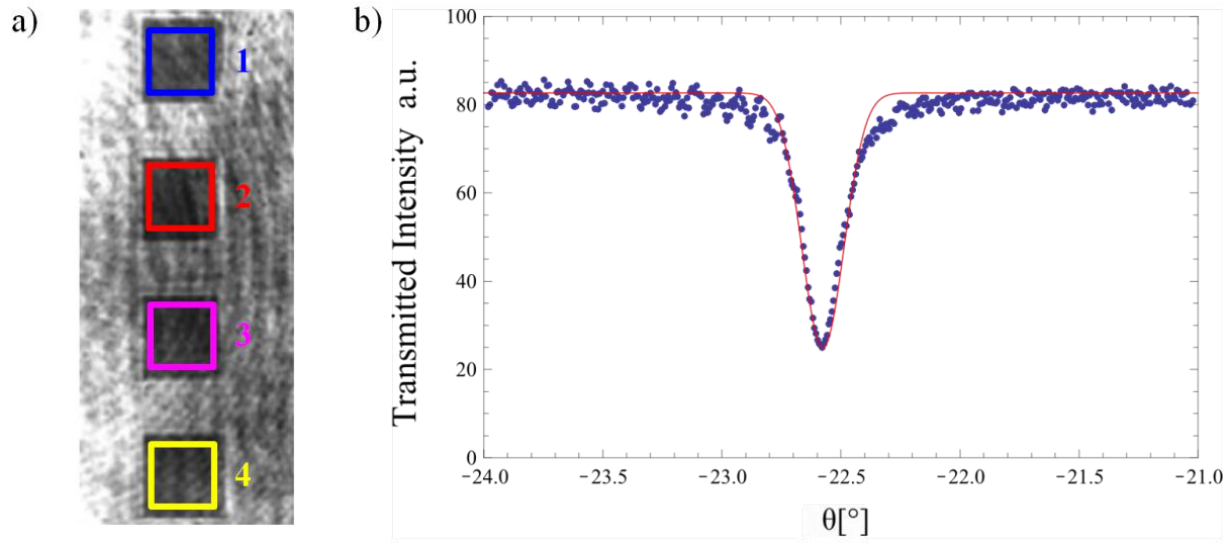
Figure 6. Typical measurement of the transmitted light intensity at the coupling angle: ( a ) CCD camera image with the four measurement regions. ( b ) Measured intensity and inverted Gaussian fit for one region to determine the coupling angle. The intensity oscillations are caused by Fresnel reflections at cover and substrate. Configuration: λ = 532.3 ± 0.2 nm, h f = 122.8 ± 0.8 nm, n c =